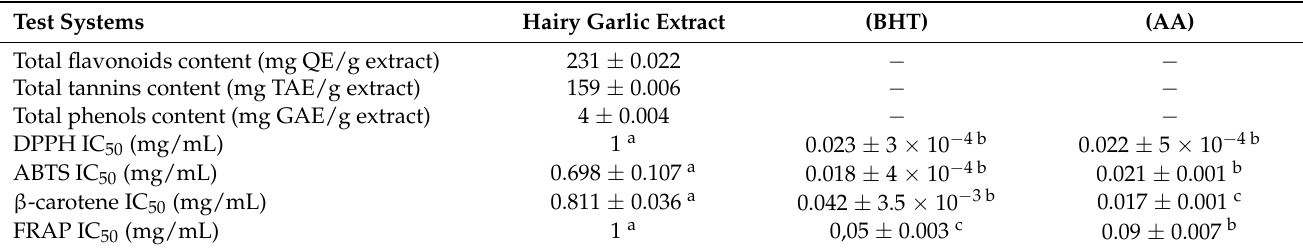
Table 3. Antioxidant activities of aqueous extract of A. subhirsutum L. (bulbs), as compared to ascorbic acid and BHT.